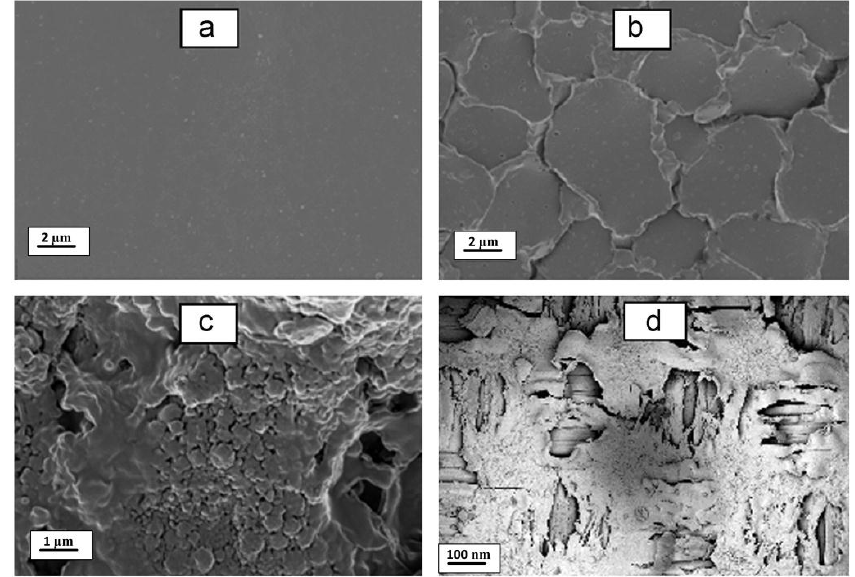
Figure 6. SEM micrographs of Neosepta ® membranes. New CEM ( a ); used CEM ( b ) and used AEM ( c , d ). Reproduced with permission from [96], copyright Elsvier, 2013.